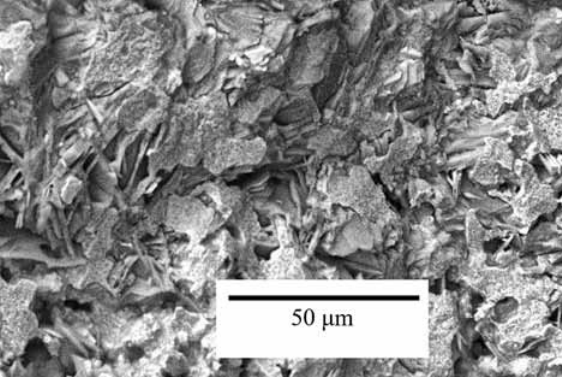
Fig. 2. The microstructure of the binder containing